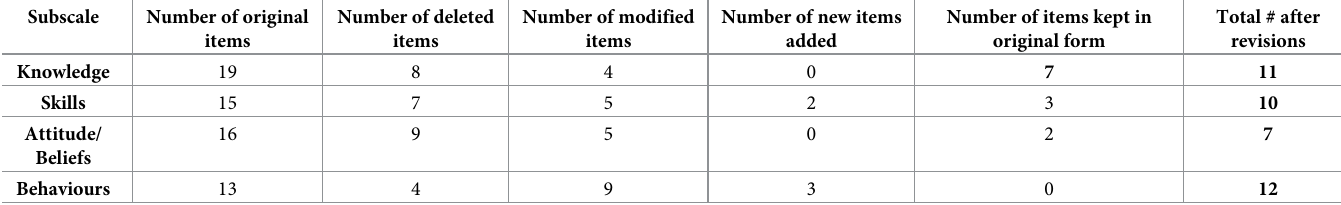
Table 2. Deleted and modified items following content validity